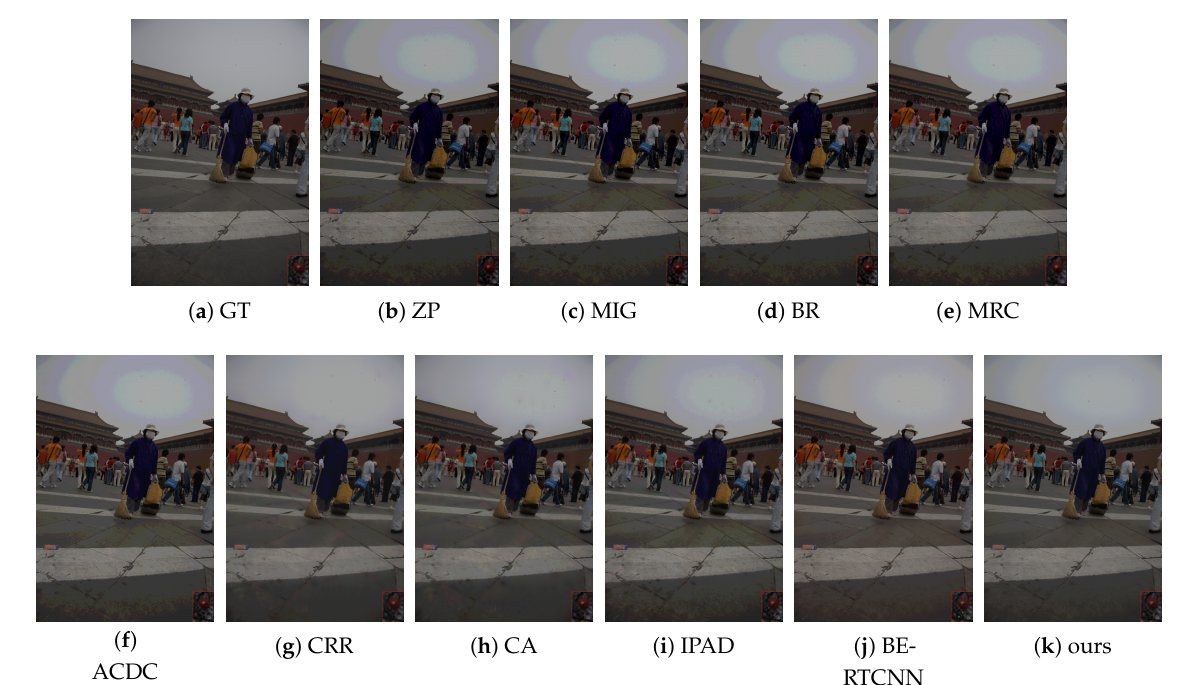
Figure 6. The BDE results on 4bit-16bit natural image from fiveK- dataset.